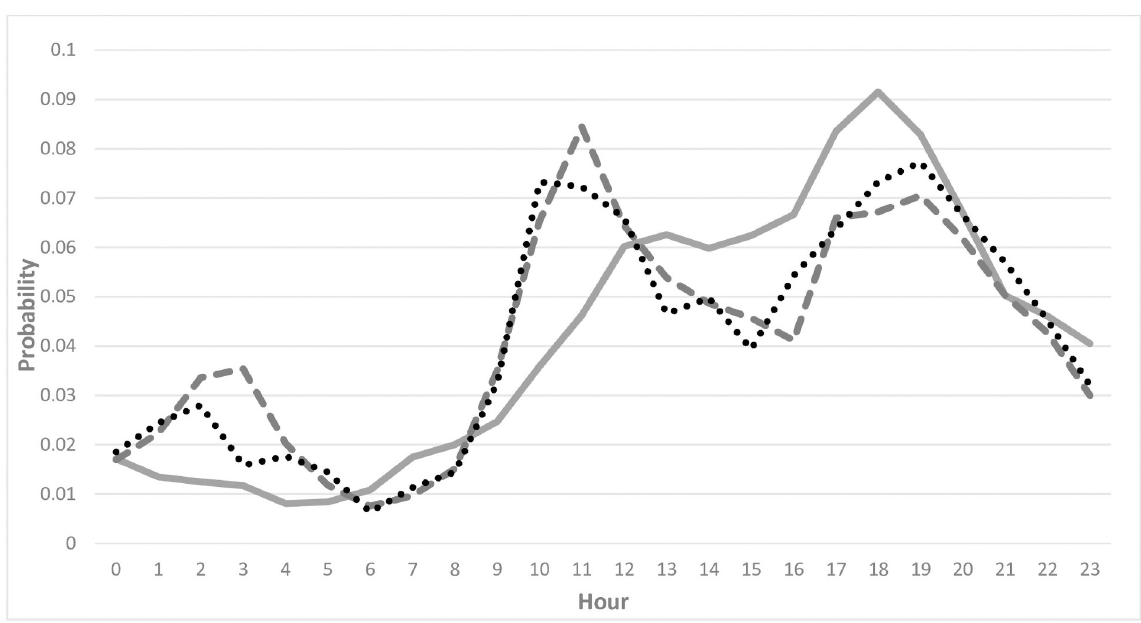
Fig 1. Hourly distributions of apartment burglaries from 2009–2012 with imprecisely (solid line) and precisely known (dashed line) time stamps; hourly distribution of apartment burglaries from 2013–2015 with precisely known time stamps (dotted